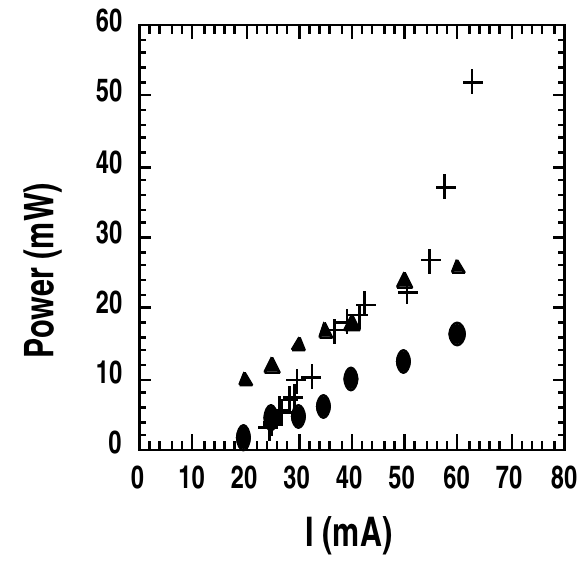
FIG. 7. Output FEL power results for the 100 MHz rf cavity only active, obtained by the STOK-2D numerical code supposing a L (cid:1) 1% and T (cid:1) 3 (cid:6) 10 (cid:3) 4 . The numerical results obtained with ( (cid:2) ) and without ( (cid:3) ) inclusion of the microwave insta- bility in the numerical code are compared with the experimen- tal data (+) already reported in Fig.